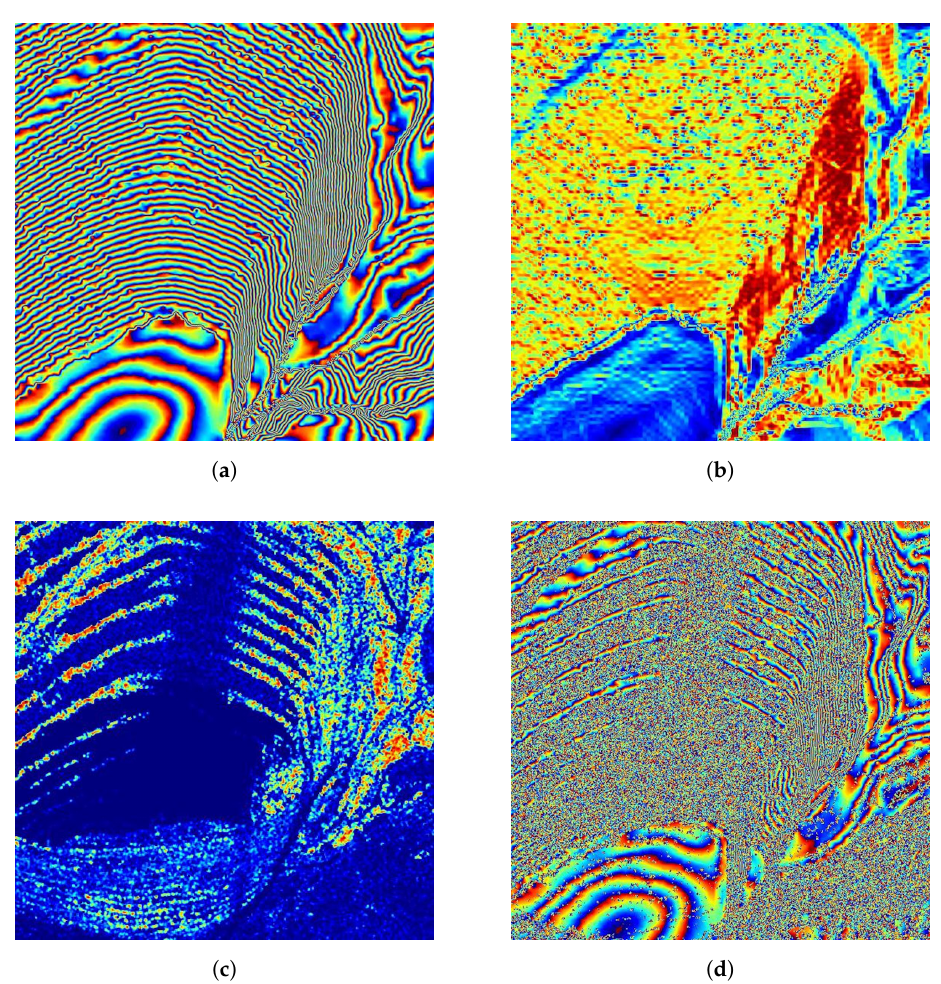
Figure 7. Example of “mixed” ground truth based on magnitude gradients and the coherence values. ( a ) Original ground truth; ( b ) magnitude gradient; ( c ) coherence; ( d ) “mixed” ground